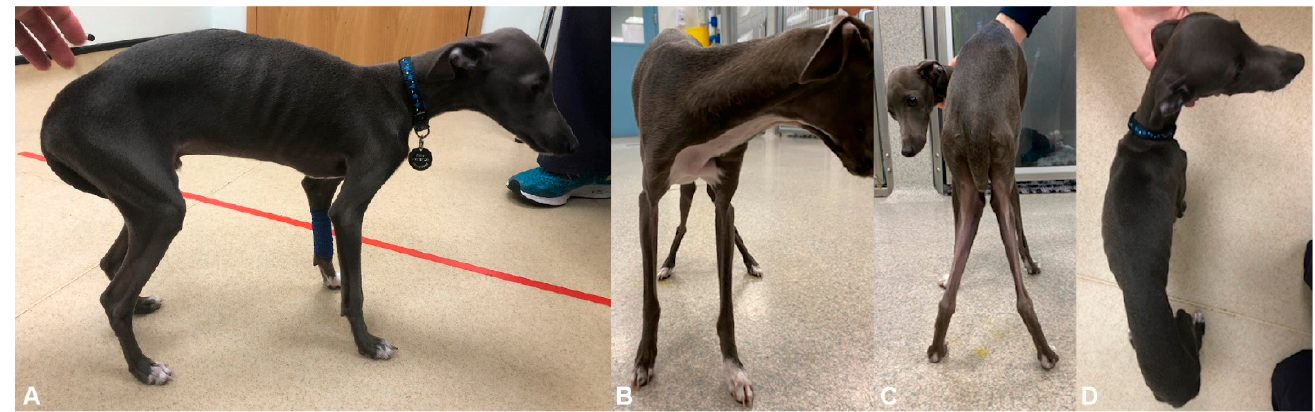
Figure 1. Clinical phenotype. Photos of affected dog illustrating kyphosis and generalized skeletal muscle atrophy on ( A ) trunk and lateral limbs, ( B ) thoracic limbs, ( C ) pelvic limbs, and ( D ) dorsum. Note genu valgum in panel ( C ).